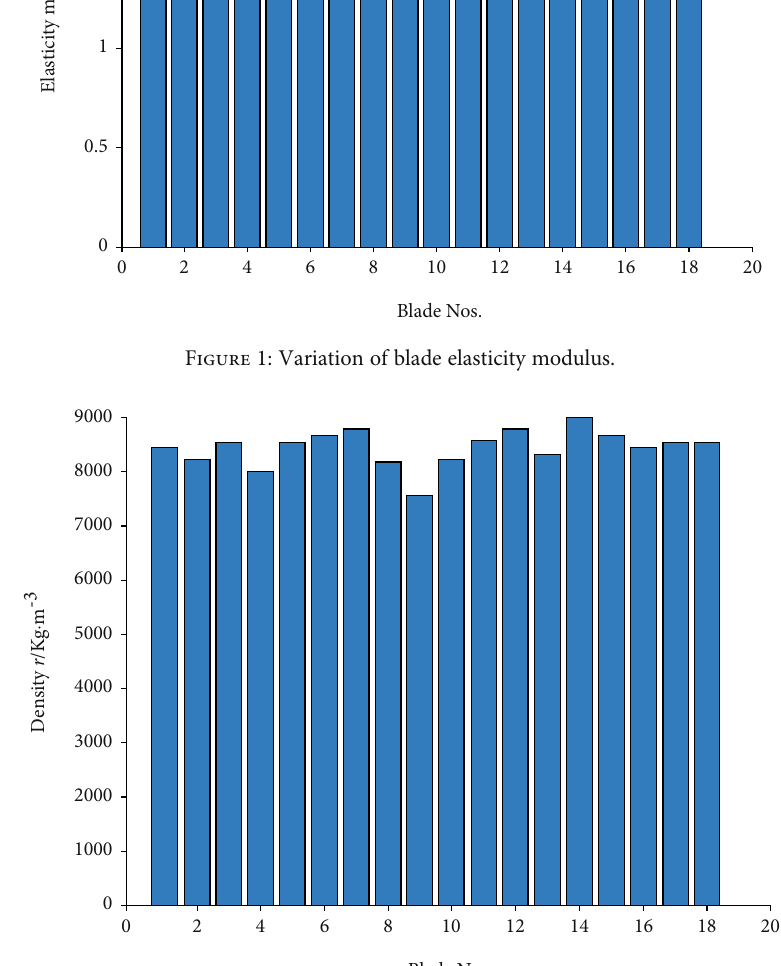
Figure 2: Variation of blade